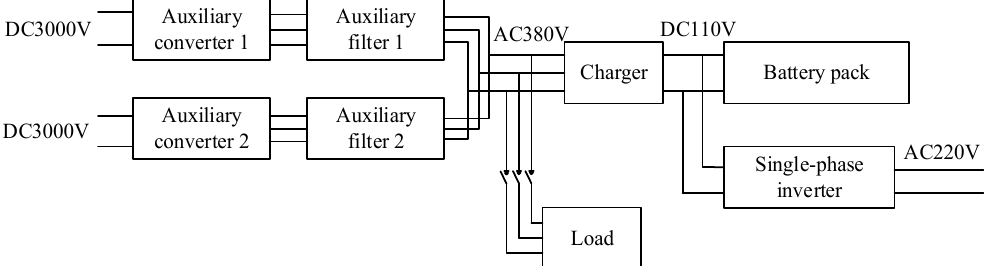
Figure 12. Diagram of the overall connection of the auxiliary power supply system.